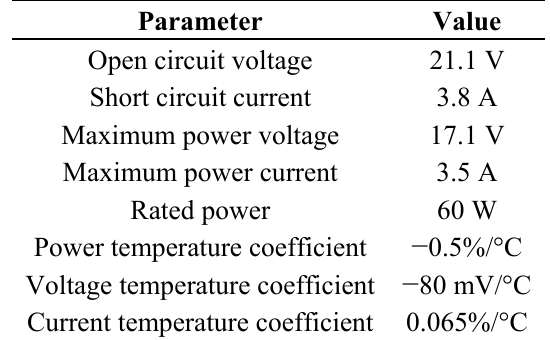
Table 1. BP-Solar MSX-60 solar array standard test conditions (STC)